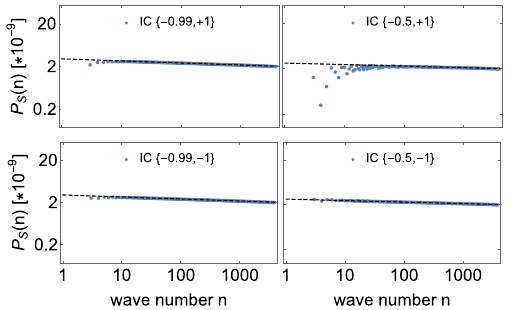
Fig. 9 Primordial scalar power spectrum for different sets of back- ground initial conditions, in the case of the quadratic potential and with fluctuations initiated before the bounce (blue dots). The dashed black line represents the standard power law. The IC for the background are: top left {− 0 . 99 , + 1 } , top right {− 0 . 5 , + 1 } , bottom left {− 0 . 99 , − 1 } , bottom right {− 0 . 5 , − 1